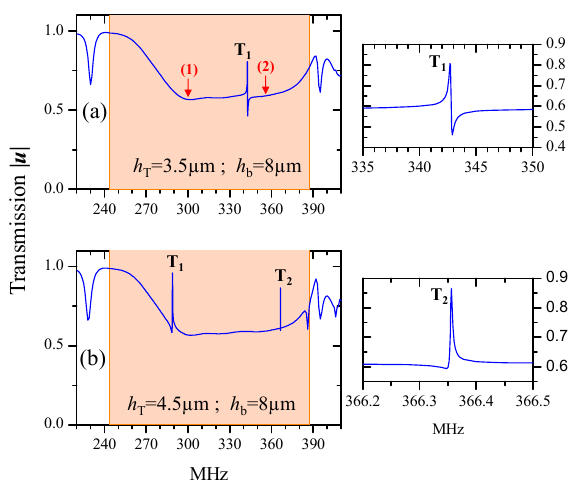
Figure 8. Transmission spectra: normalized total displacement’s amplitude for h T = 3.5 µm ( a ) and h T = 4.5 µm ( b ). The bottom Si layer thickness is fixed to h b = 8 µm. The right panels are zooms of the peaks of interest for each transmission curve.